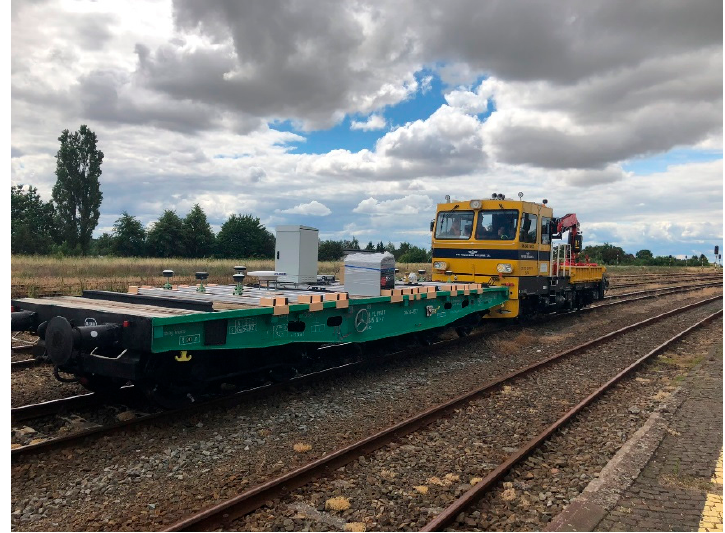
Figure 1. Mobile surveying platform.